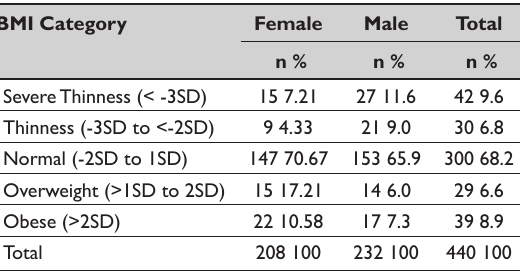
Table 3: Nutritional status of school-aged